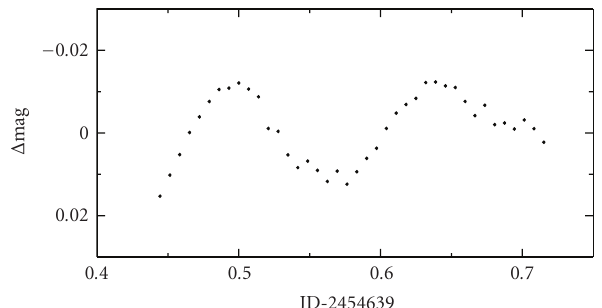
Figure 3: Light curves of HD 163032 from data taken on 18 May 2007 at Teide. The exposure time was 560 seconds. No filter was used in this observation. HD 163032 is an A5 star with m V = 8